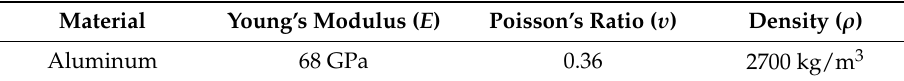
Table 1. Material properties of housing.